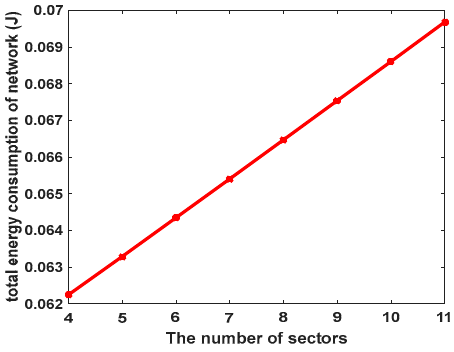
Figure 5. The comparison of data transmission range of MNs in CCWSN and SCWSN.